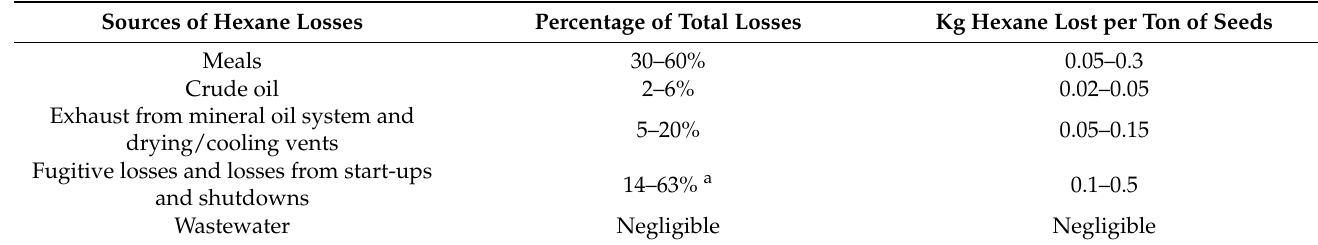
Table 4. Hexane losses in the oilseed crushing industry.